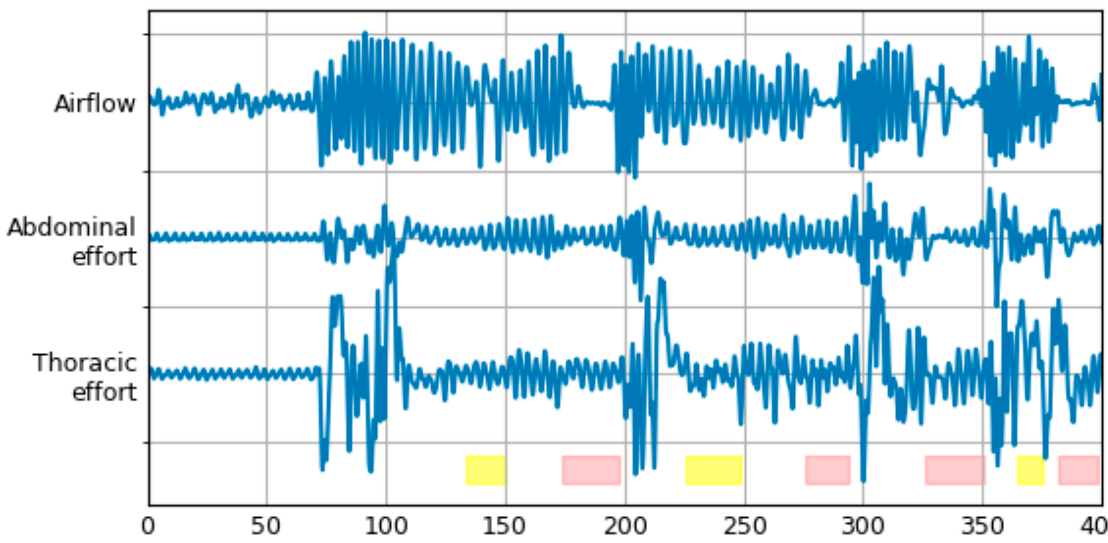
Figure 2. Respiratory signals from one of the SHHS-1 recordings, after preprocessing stage. At the bottom, there are bars representing labels from the database: red for apnea, yellow for hypopnea episodes.